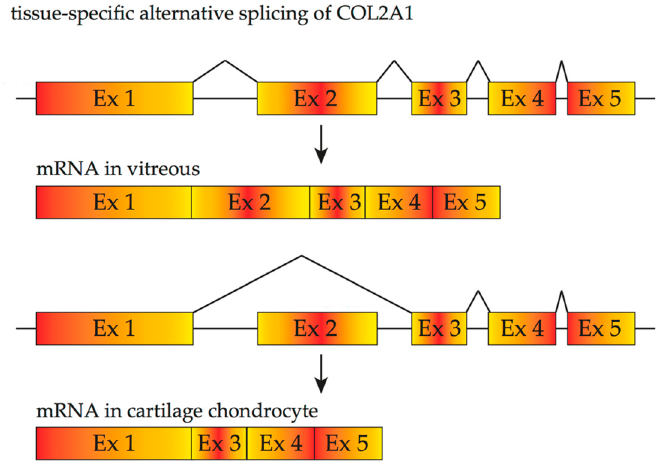
Figure 3. Tissue-specific alternative splicing of COL2A1 . COL2A1 mRNA containing exon 2 is primarily found in vitreous hyalocyte while mRNA lacking of exon 2 is found in cartilage chondrocyte.